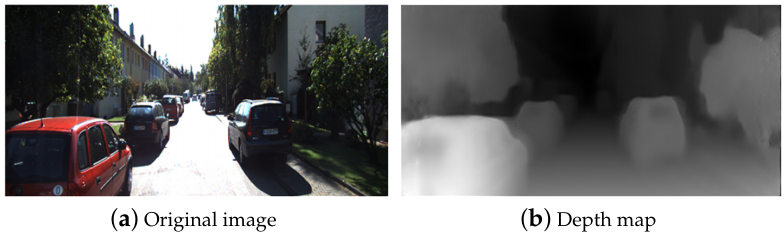
Figure 2. Depth map from mono-depth